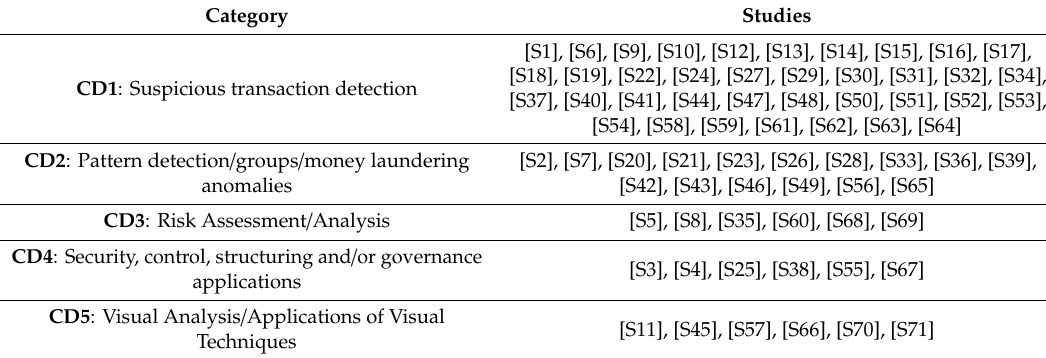
Table 10. Application domain